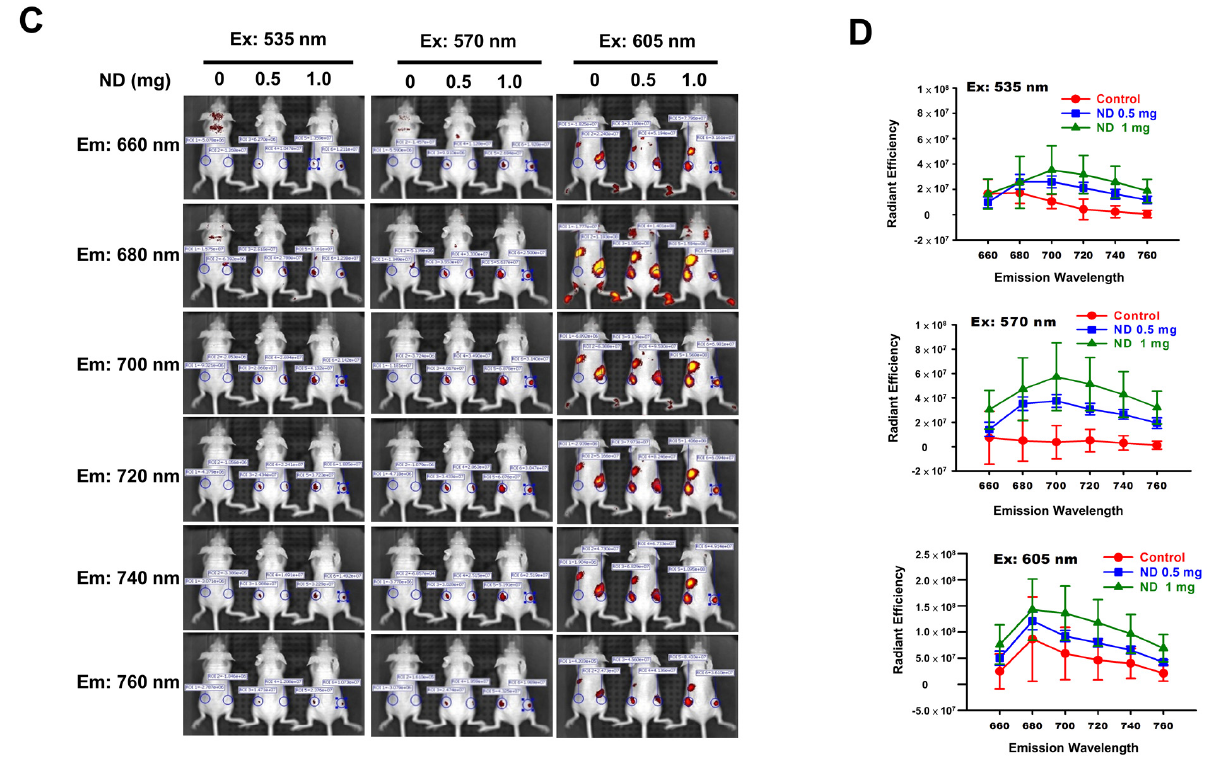
Figure 1. Optimal fluorescence intensities of ND particles in vitro and in vivo under IVIS system. ( A ) Various concentrations of ND particles were loaded in 96-well plates. (a–j) Serial dilutions of the 96-well plates were prepared by mixing 100 µ L PBS. IVIS conditions used Bin: 4; FOV: 13.3; f2; 1s. Excitation wavelengths: 350 nm, 570 nm, and 605 nm. Emission wavelength range: 660–760 nm. ( B ) The relative fluorescence signal in ROI region was quantified by IVIS software. ( C ) The fluorescence intensities of ND particles by subcutaneously injection in nude mice. Fluorescent imaging in the anesthetized mouse injected subcutaneous with three nude mice for a group, the left mice injected 100 µ L PBS, middle-treated with 0.5 mg/100 µ L PBS, and the right mice treated with 1 mg/100 µ L PBS. Excitation wavelengths: 350 nm, 570 nm, and 605 nm. Emission wavelength range: 660–760 nm. (Bin: 4, FOV: 13.3, f1, 2s). ( D ) The relative fluorescence signal in ROI region was quantified using Living Image 4.0